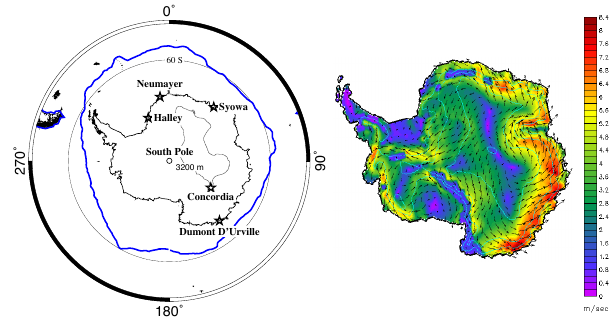
Figure 1. Left: map of Antarctica showing the inland sites of the South Pole and Concordia, the coastal sites of Dumont d’Urville and Syowa in East Antarctica, and Neumayer and Hal- ley in West Antarctica. The blue line refers to the mean loca- tion of the sea ice edge in the end of winter (August) over the period 1981–2012 (NOAA_OI_SST_ V2 data provided by the NOAA/OAR/ESRL PSD, Boulder, Colorado, USA, http://www. esrl.noaa.gov/psd). Right: average wind speeds and wind vectors at 2ma.g.l. in December 2009 and January 2010, as simulated by the MAR model nested in the European reanalyses (ERA-Interim) with a horizontal resolution of